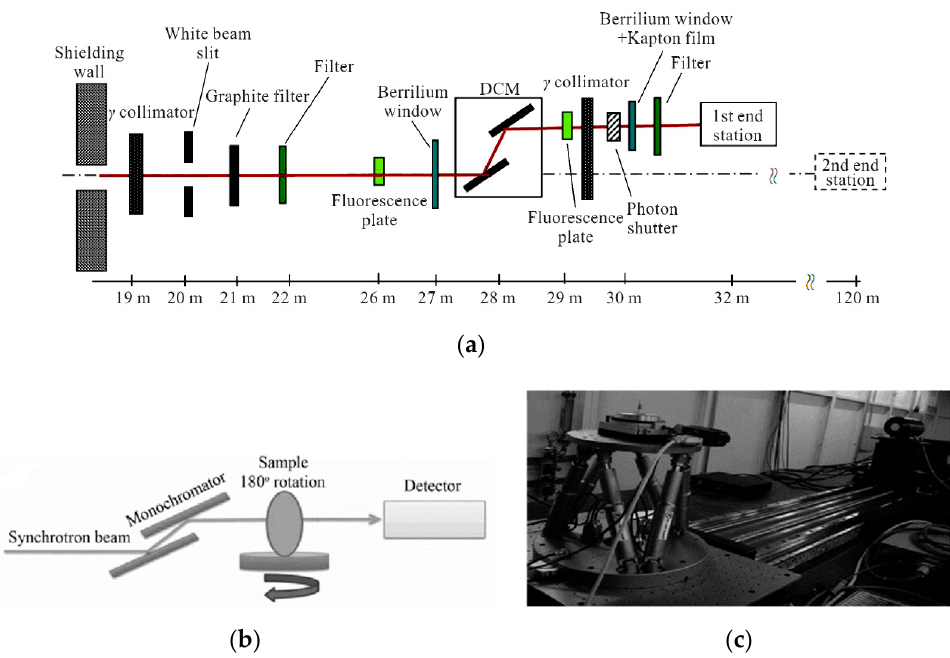
Figure 1. Schematics of the BL13W1 beamline at SSRF ( a ) experimental station, ( b ) detailed schematic diagram, and ( c ) photograph of the IL-XPCT system [21].